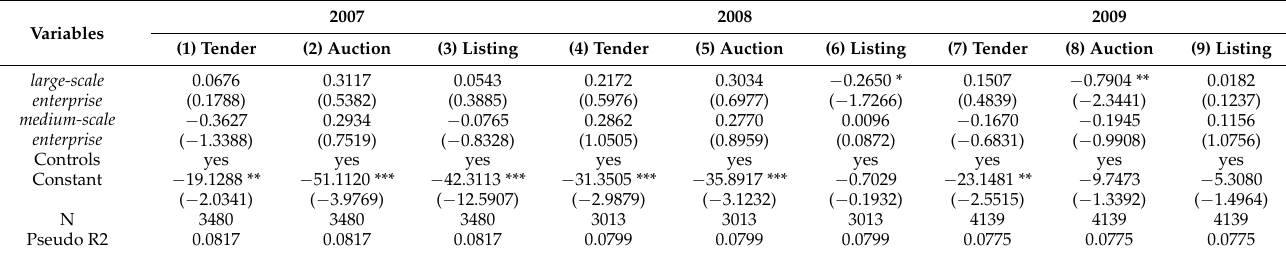
Table A5. Results of mlogit model considering scale of enterprises